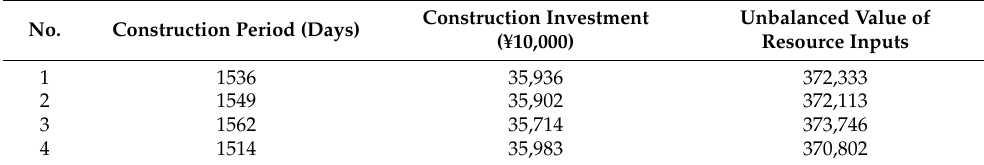
Table 5. Pareto solution set with priority of reducing